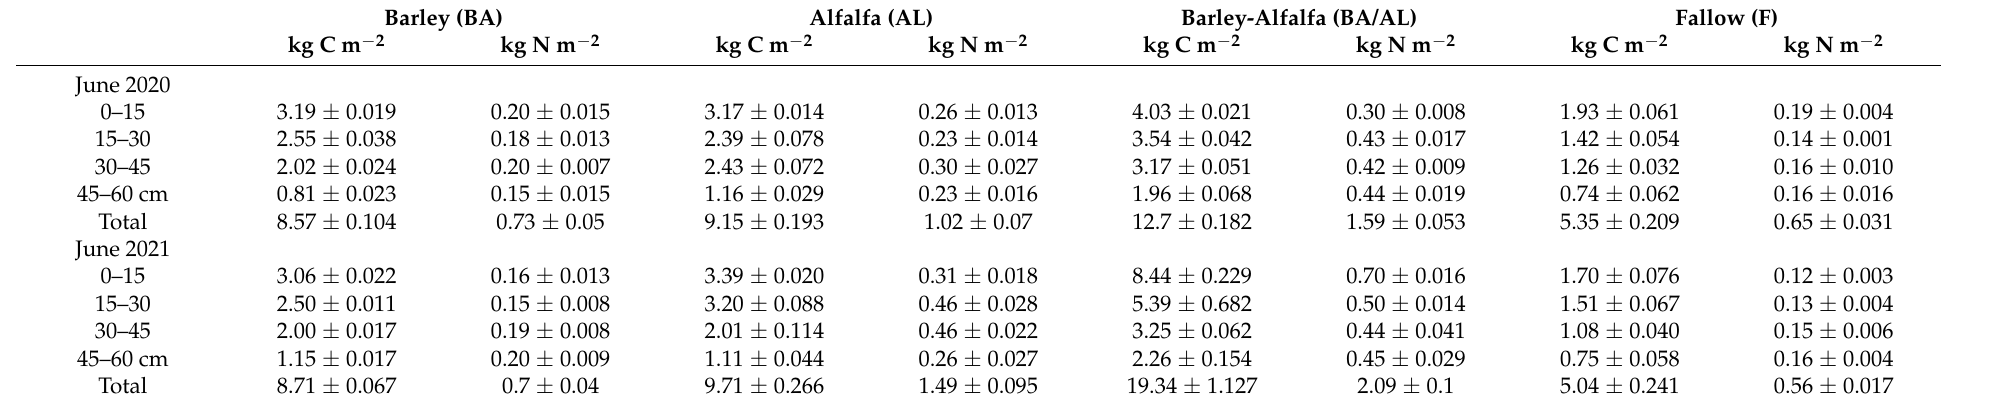
Table 4. Soil organic carbon and soil total nitrogen stocks at the four sub-plots between 2020 and 2021.